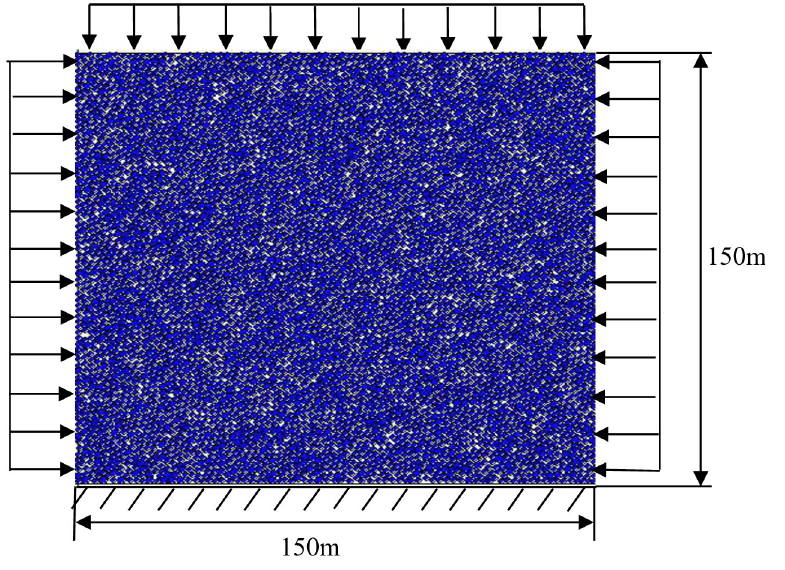
Fig 2. Illustration of the PFC numerical